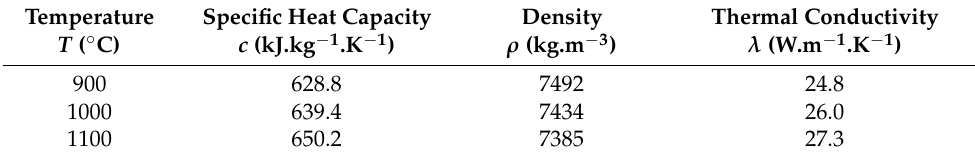
Table 1. Thermo-dynamic properties of the 55NiCrMoV7 steel depending on temperature. Temperature